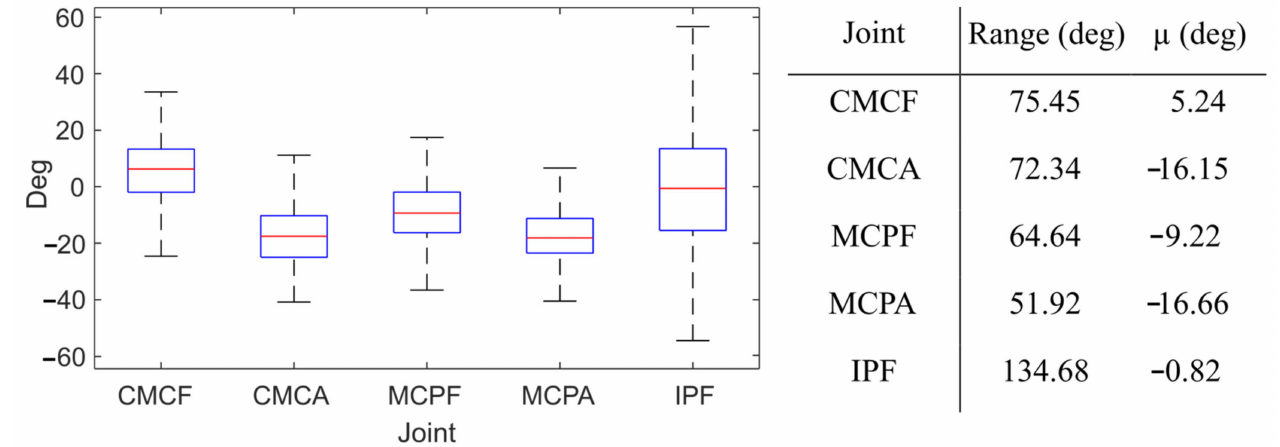
Figure 3. Left: Box plot with angles recorded across postures. The horizontal marks in the center of the boxes are the median; the edges of the boxes are the 25th and 75th percentile; whiskers extend to 1.5 times the interquartile range. Right: range (maximum minus minimum) and average values ( µ ) of each joint movement. Positive values represent flexion and adduction angles; negative values represent extension and abduction angles. CMC abduction/adduction (CMCA) and flexion/extension (CMCF); MCP abduction/adduction (MCPA) and flexion/extension (MCPF); and IP flexion/extension